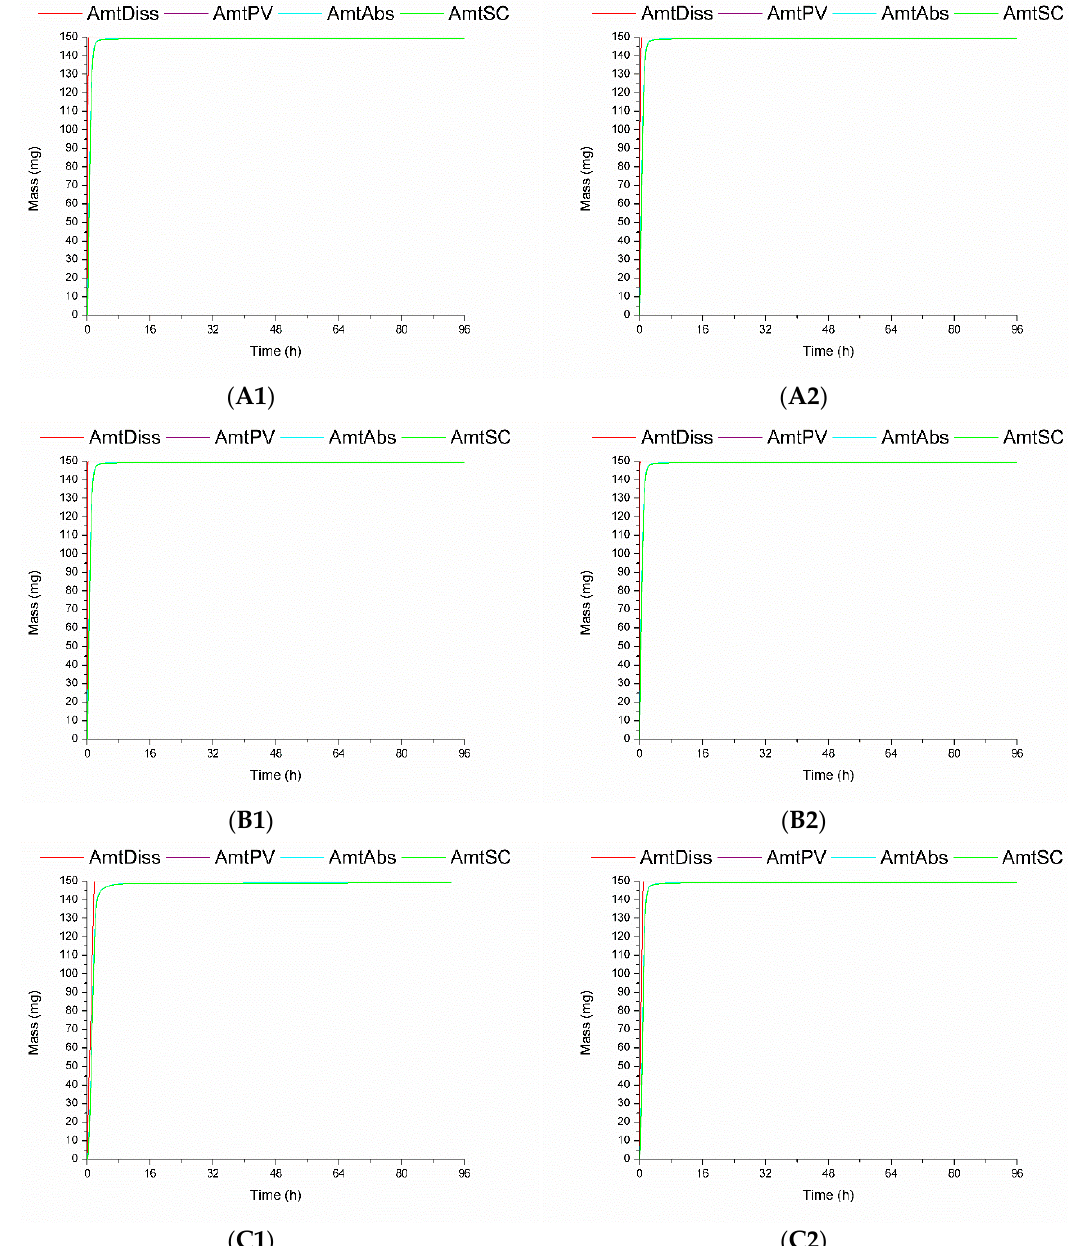
Figure 3. Amount of fluconazole dissolved in vivo (AmtDiss), amount absorbed to the portal vein (AmtPV), total amount absorbed (AmtAbs), and the amount in the systemic circulation (AmtSC) for products A1 , A2 , B1 , B2 , C1 , and C2 calculated by GastroPlus™. Simulation time displayed is 8 h instead of the total simulation time (96 h) to provide better visualization.